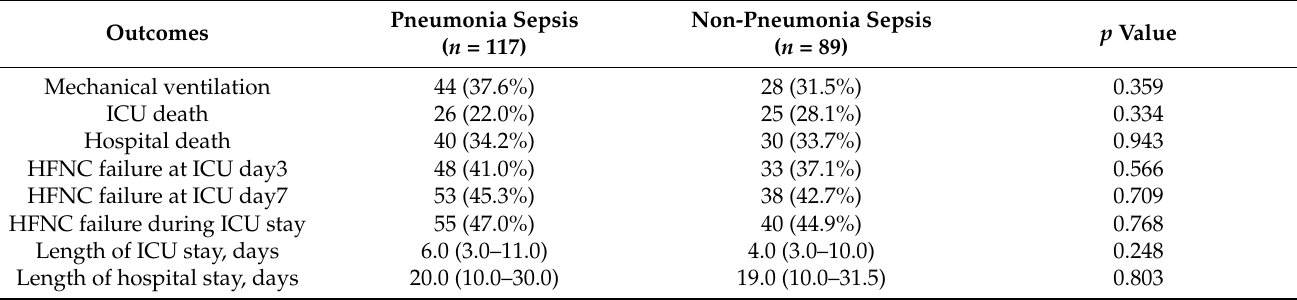
Table 2. Treatment outcomes among enrolled patients ( n =